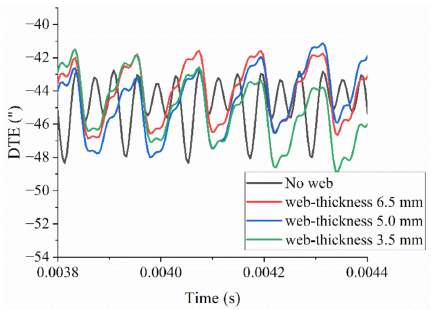
Figure 6. Dynamic transmission error of models with different web thickness.